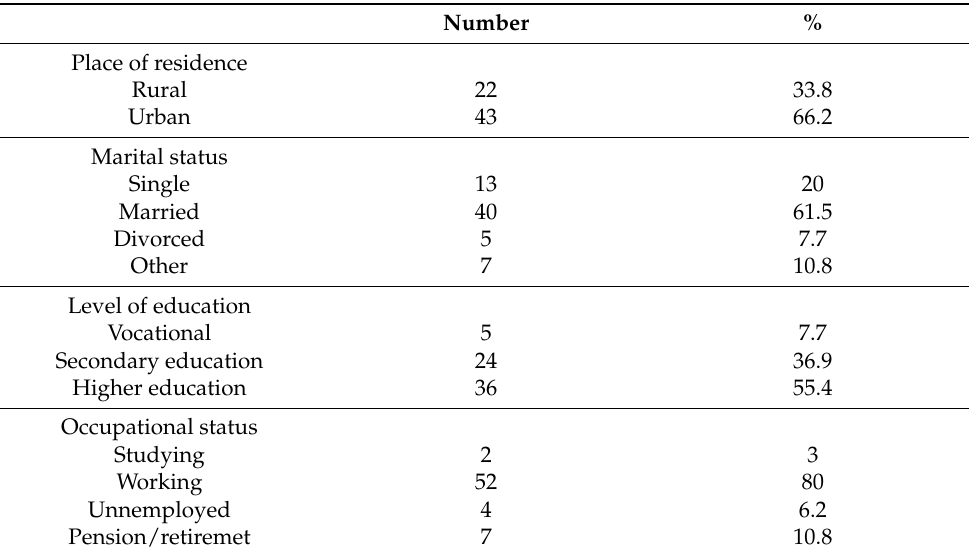
Table 2. Geographical (place of usual residence) and social characteristics of the group of MS patients ( n =